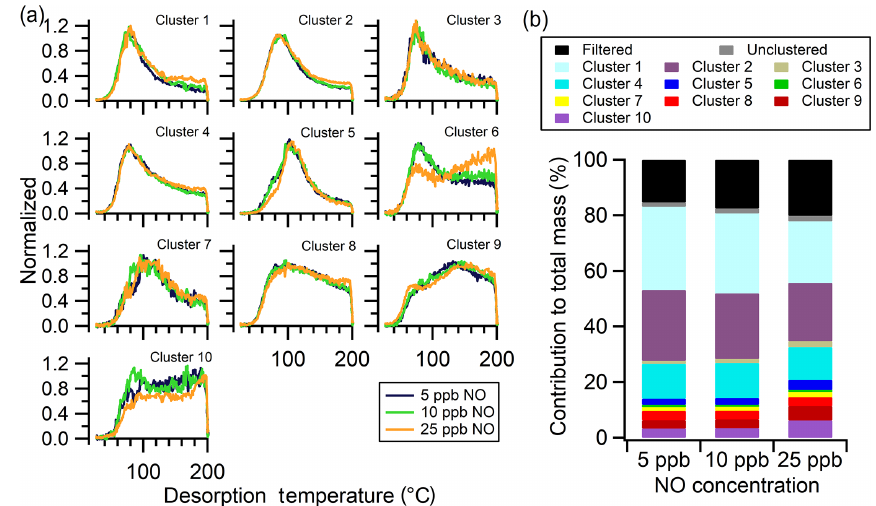
Figure 9. Single-clustering results for α -pinene + OH SOA as a function of NO concentration. (a) Comparison of the normalized, weighted average thermograms of the 10 clusters for the 5ppb NO (navy), 10ppb NO (green), and 25ppb NO (orange) experiments. (b) Contribution of each cluster to the total mass, including the contribution from filtered-out ions (black) and unclustered ions (gray). The total mass is calculated independently for each